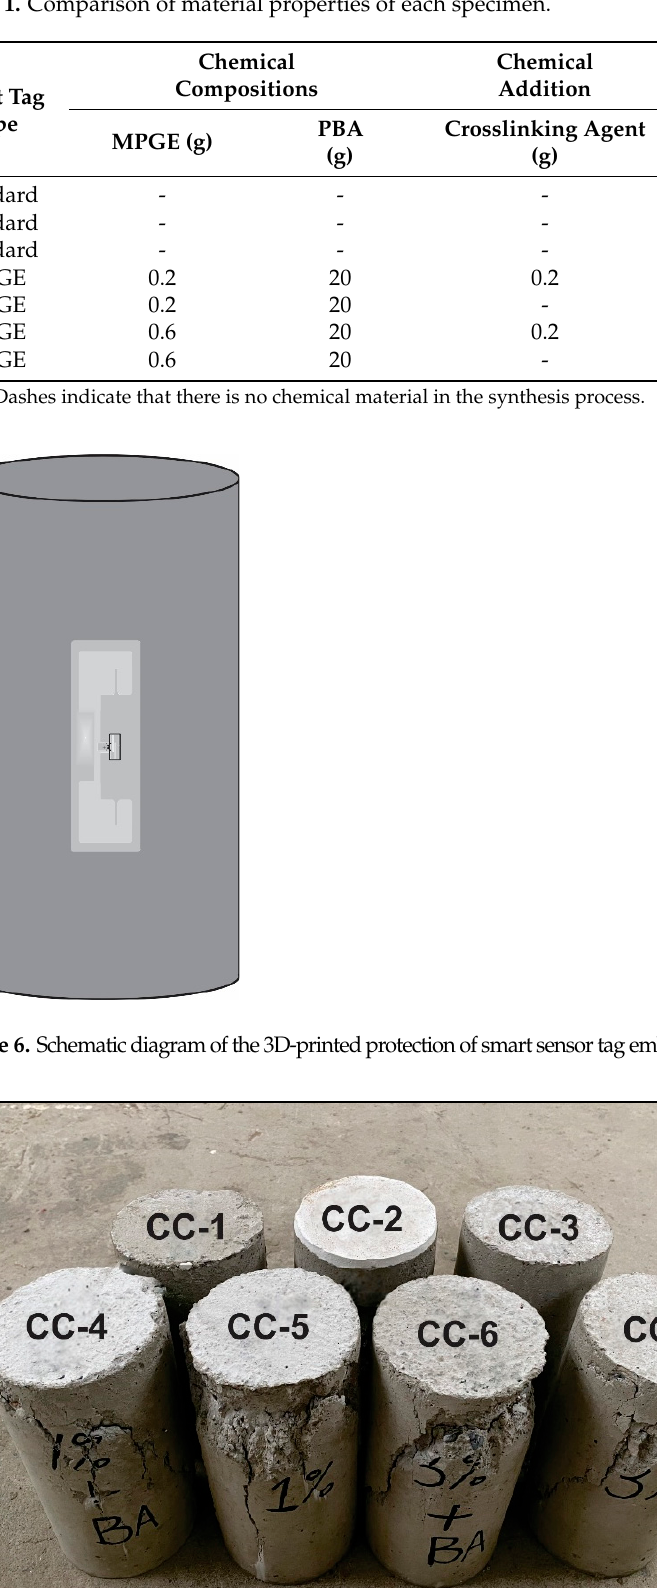
Table 1. Comparison of material properties of each specimen.